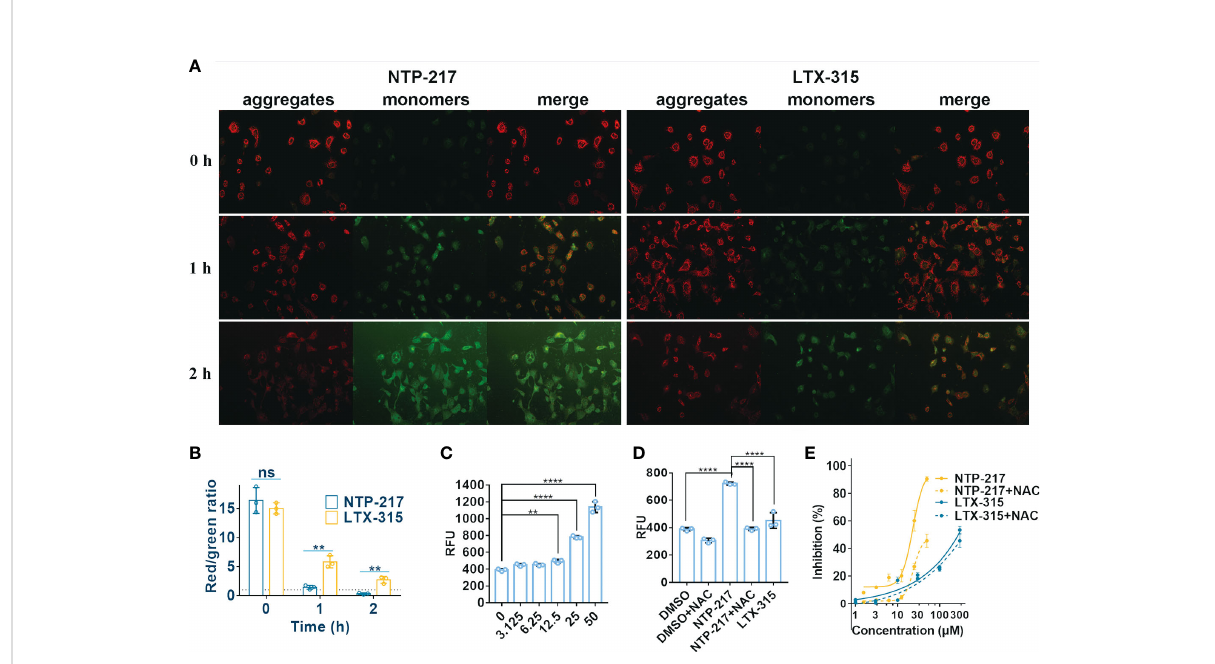
FIGURE 6 Decrease in mitochondrial membrane potential and increase in ROS level caused by NTP-217. (A) Hepa 1-6 cells treated with 25 m M NTP-217 or LTX-315 were subsequently labeled with JC-10 (objective magni fi cation, x10). (B) Quanti fi cation of fl uorescent intensity using ImageJ software (n=3). The results are presented as the mean ± SD. Student ’ s t-test. (C) ROS levels in Hepa 1-6 cells incubated with a series of concentrations of NTP-217 for 1 h were measured using fl uorometric analysis (n=3). The data are presented as the mean ± SD. (D) ROS levels were measured